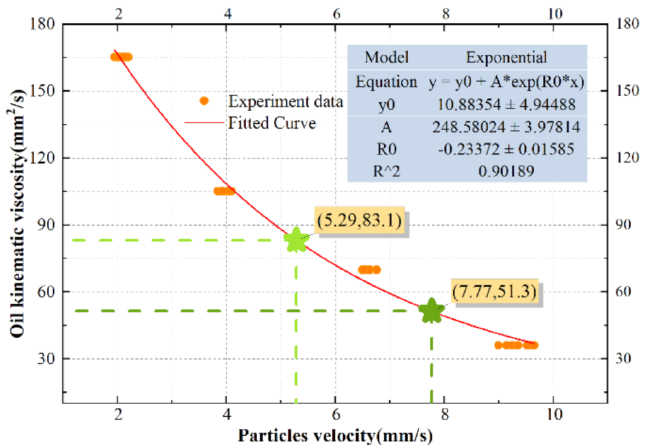
Figure 10. Oil viscosity measurement curve based on nonlinear exponential regression